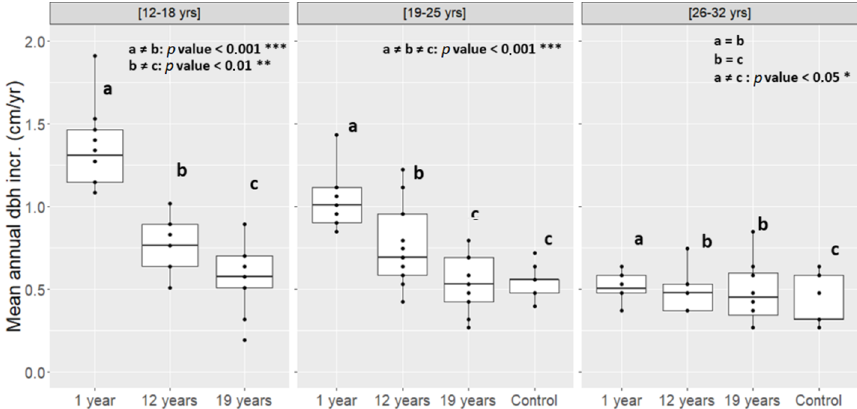
Figure 6. Boxplot of the mean annual dbh increment during age intervals 12–18, 19–25, and 26–32 years in site 6. Significant differences were tested with a Tukey test. Significantly different groups are denoted with different letters.